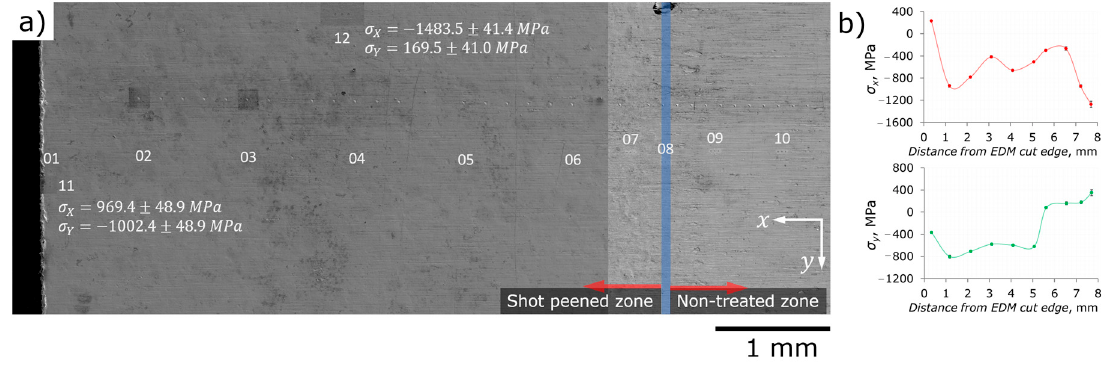
Figure 8. FIB-DIC evaluation of RS at the surface in the Transition zone specimen: ( a ) location of FIB-DIC probing; ( b ) profile of RS along the x and y